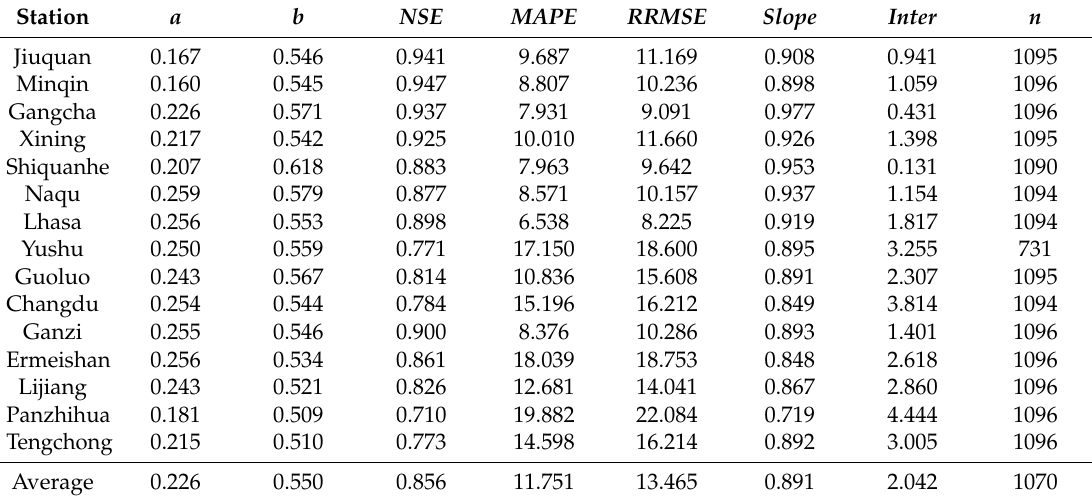
Table 6. Performance of the improved Ångström-type